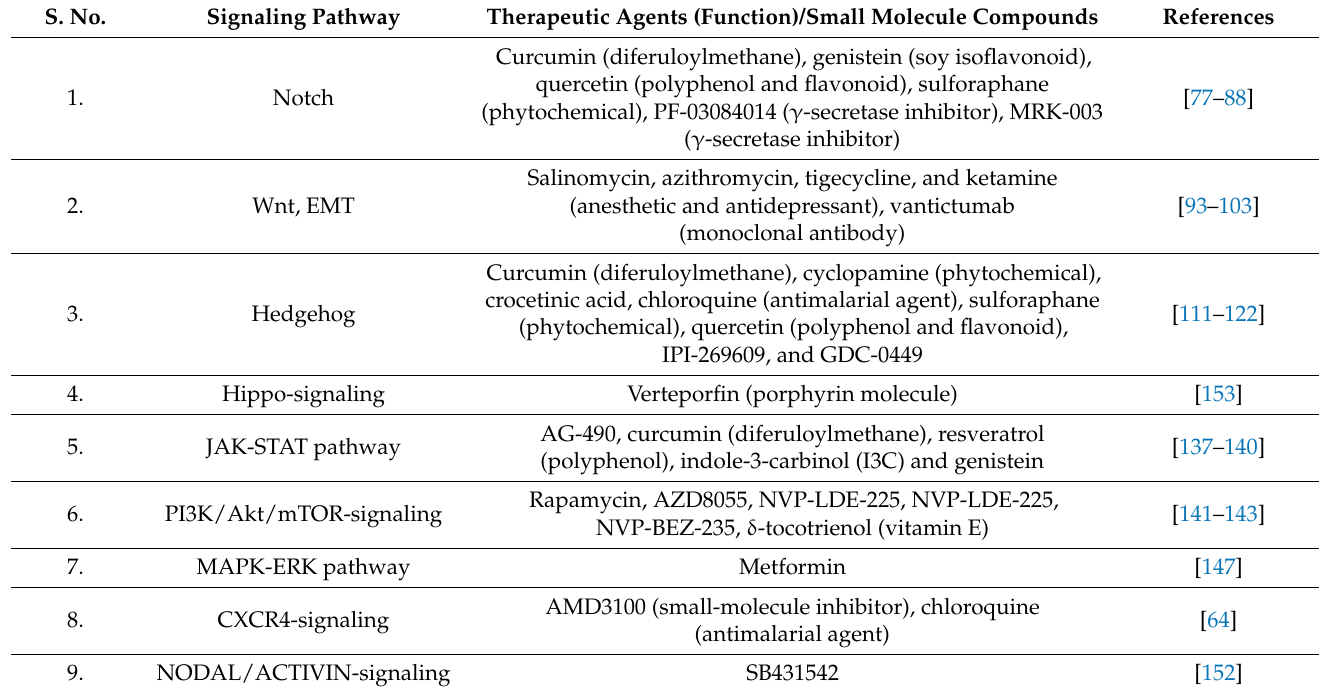
Table 2. Summary of therapeutic agents targeting different signaling and PaCSCs. S.